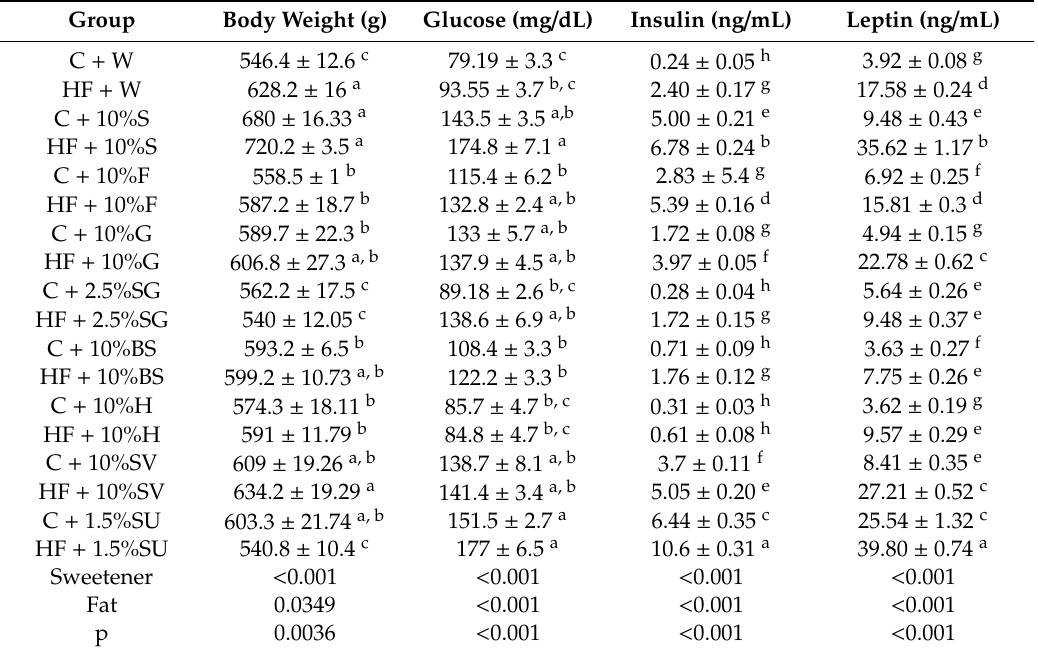
Table 1. Body weight and serum biochemical parameters of rats fed natural or artificial sweeteners with and without high